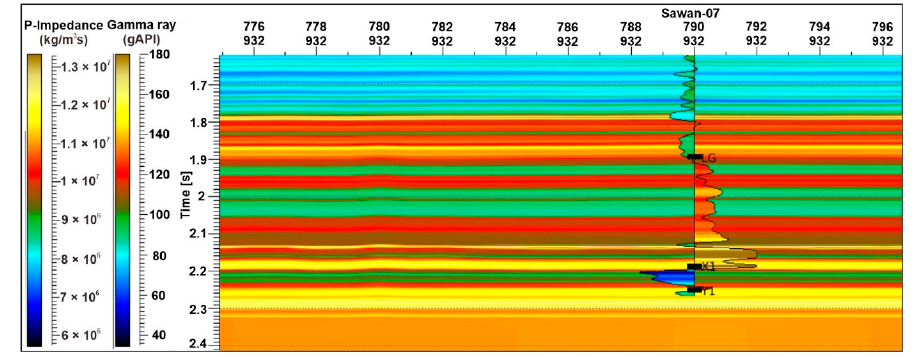
Figure 8. Earth model with GR overlay, which highlights the ZOI with blue filling representing low- GR values. low-GR